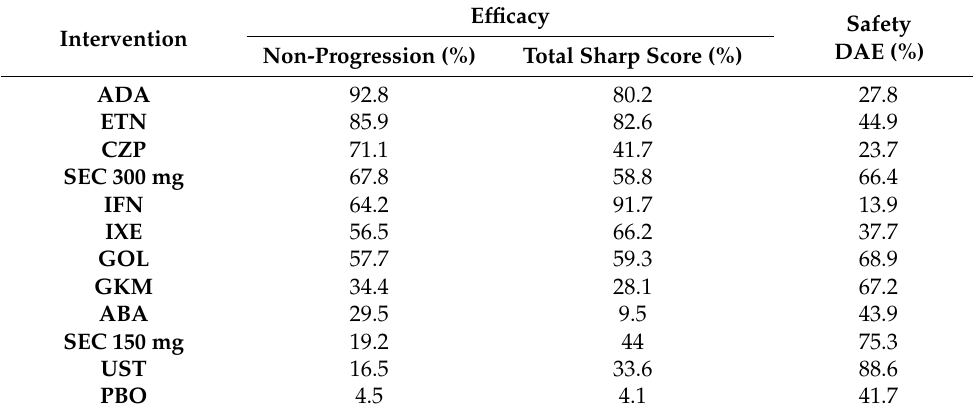
Efficacy Safety